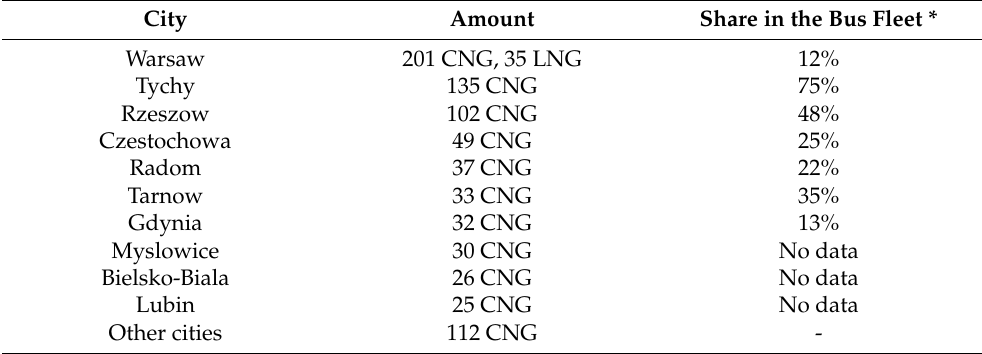
Table 2. CNG/LNG urban buses in polish cities in December 2020. Selected cities are included [57]. City Amount Share in the Bus Fleet * Warsaw 201 CNG, 35 LNG 12% Tychy 135